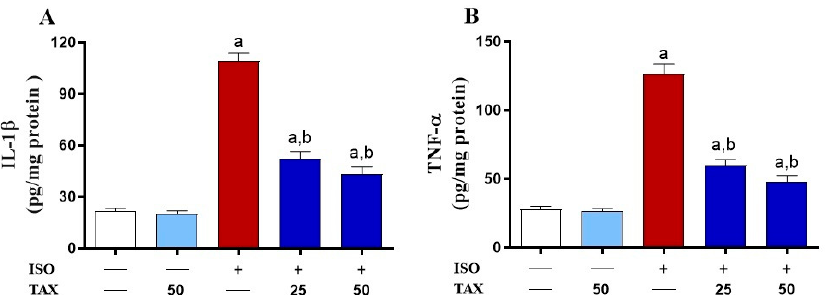
Figure 6. TAX reduced the ISO-induced increased myocardial ( A ) IL-1 β and ( B ) TNF- α . Data are expressed as mean ± SEM, ( n = 6). Here, a indicates significant ( p < 0.05) vs. control, while b indicates significant ( p < 0.05) vs. ISO.